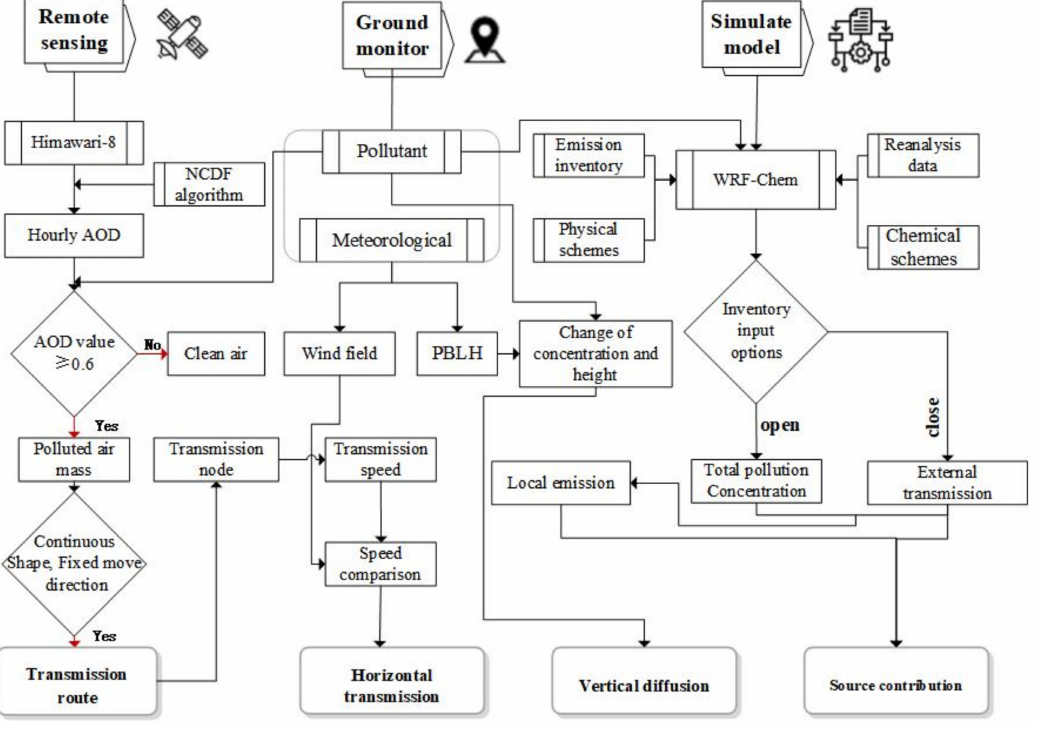
Figure 5. Flow chart of regional transmission and source contribution of fine particulate matter